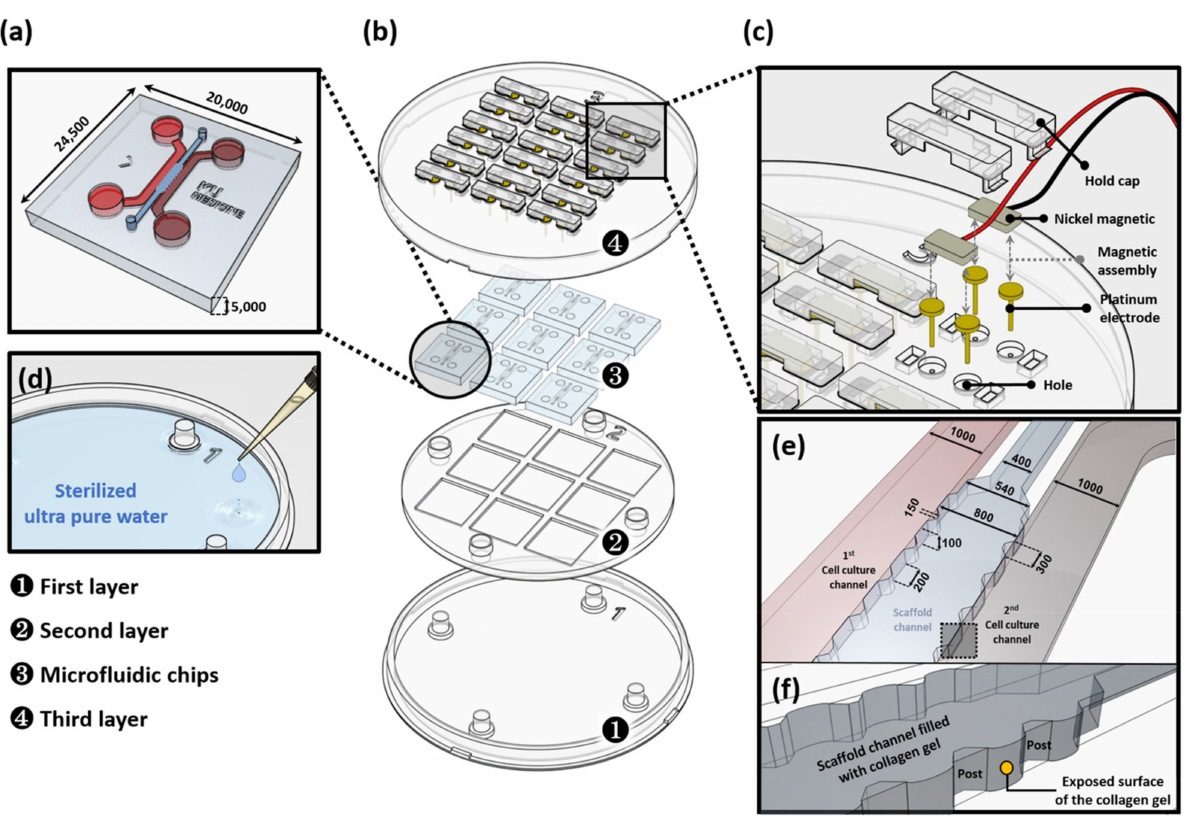
Figure 1. Low constant-current stimulation (LCCS) platform. ( a ) Microfluidic chips with two distinct chambers that are connected through a thin collagen hydrogel channel such that various reagents can diffuse, and a 3D biological structure is formed (e.g., vascular structure) by an interaction between cells and reagents in different chambers. ( b ) Expanded view of the components of the LCCS platform, including co-culture microfluidic chip and the LCCS stimulator. ( c ) Expanded view of the LCCS stimulator. ( d ) Reservoir in the LCCS platform for controlling humidity. ( e ) Schematic of the microfluidic channels including cell culture channels and a scaffold channel. ( f ) Magnified image of the scaffold channel indicated by dotted line box in the ( e ) panel. All scale bars are represented as µ